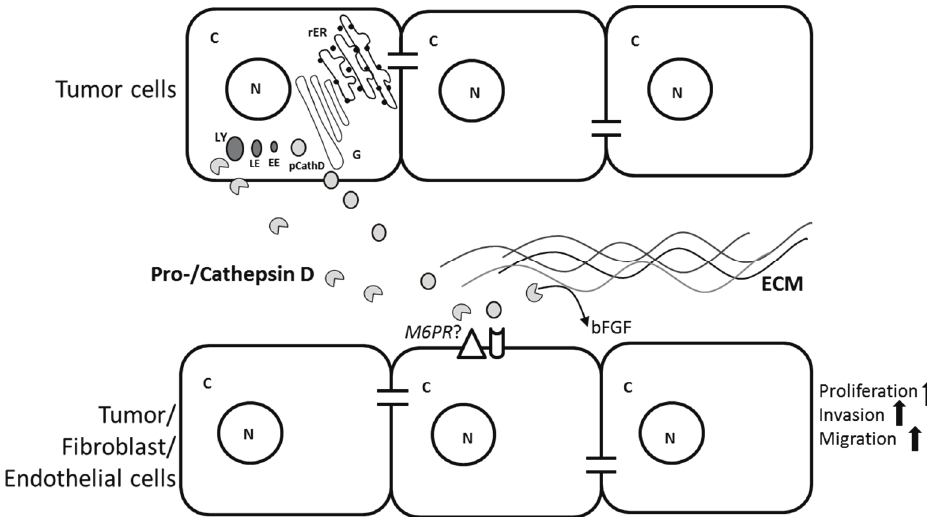
Figure 1. Potential roles of tumor cell-secreted procathepsin/cathepsin D (pCathD/CathD) on extracellular matrix (ECM), tumor, fibroblast and endothelial cells in the tumor microenvironment. pCathD is synthesized and processed in the rough endoplasmic reticulum (rER) and Golgi bodies (G), and subsequently transported to early endosome (EE), late endosome (LE) and finally lysosome (LY). Overexpressed pCathD/CathD is secreted into the extracellular space by tumor cells. Mature CathD cleaves ECM and releases basic fibroblast growth factor (bFGF) that may induce angiogenesis. Both pCathD and CathD induce tumor cell proliferation, and hence invasion via an autocrine mechanism. CathD induces proliferation of fibroblasts and migration of endothelial cells. Mannose-6-phosphate receptor (M6PR) may be involved in inducing the proliferative effects. C and N denote cytoplasm and nucleus,